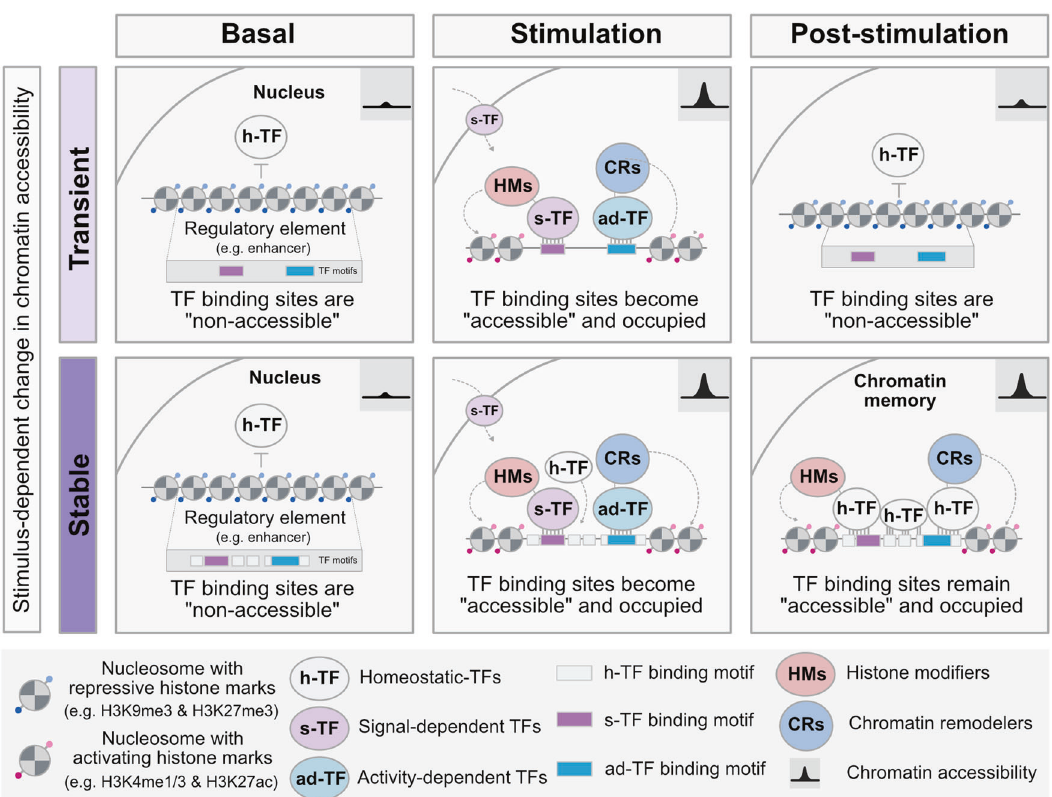
Fig. 1 TF-dependent establishment and maintenance of chromatin memory. Model illustrating a TF-dependent mechanism for the establishment of transient (top) or stable (bottom) changes in chromatin accessibility at regulatory elements (inspired by fi ndings reported in [10, 13, 74, 95, 97, 100, 101, 104, 121 – 123]. Left: in basal state, nucleosomes with repressive histone modi fi cations, i.e., H3K9me3 and H3K27me3 (and with DNA methylation, not depicted in the fi gure) at a regulatory element, i.e., enhancer, represent a barrier for TF binding via occlusion of binding motifs [95, 122, 123]. Homeostatic TFs (h-TF) cannot stably bind nor initiate chromatin remodeling to displace nucleosomes, regardless of the underlying DNA sequence (top or bottom). Middle: Upon stimulation such as neuronal activation or in fl ammation, a type of TFs termed signal-dependent (s-TF), i.e., STAT3, present at the nuclear membrane is activated [101] then translocates to the nucleus where it binds to DNA binding motifs located at regulatory elements in a chromatin context otherwise non-accessible to h-TF [101, 124, 125]. This is accompanied by the recruitment of chromatin remodeling (CR) complexes that induce nucleosome mobilization and histone modi fi cations which results in the exposure of additional TF binding motifs making the regulatory element “ accessible ” [10, 13, 126]. s-TFs induce the transcription of another class of TFs, termed activity-dependent (ad-TF), i.e., AP-1 class such as c-Fos or Egr1, which can be recruited to newly accessible regulatory elements and activate these elements by recruiting RNA Pol II and DNA demethylases [13, 101]. Regulatory elements with increased chromatin accessibility can also be occupied by h-TF. In this scenario, h-TF binding depends on the sequence of the regulatory element and its accessibility determined by epigenetic modi fi ers recruited by s-TF and ad-TF. The transient versus stable state is determined by the nature and number of TF binding motifs in the regulatory element. Right: After stimulation, the majority of responsive regulatory regions return to a basal state of chromatin accessibility (Transient). Responsive regions with chromatin memory have persistent changes in chromatin accessibility, here shown as a gain in accessibility resulting from h-TF binding (Stable). Depicted histone modi fi cations are only those mentioned in the text, many other modi fi cations exist but are not drawn for simplicity. Additional mechanisms may also contribute to the formation of chromatin memory in the